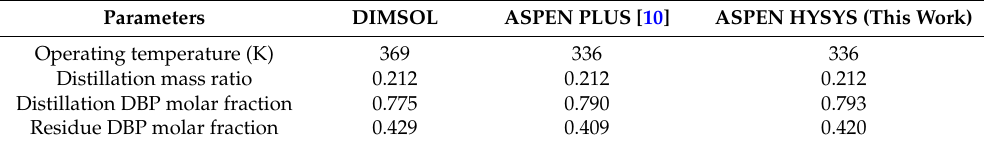
Table 1. Results of the DISMOL simulator, ASPEN PLUS and that developed in ASPEN HYSYS.